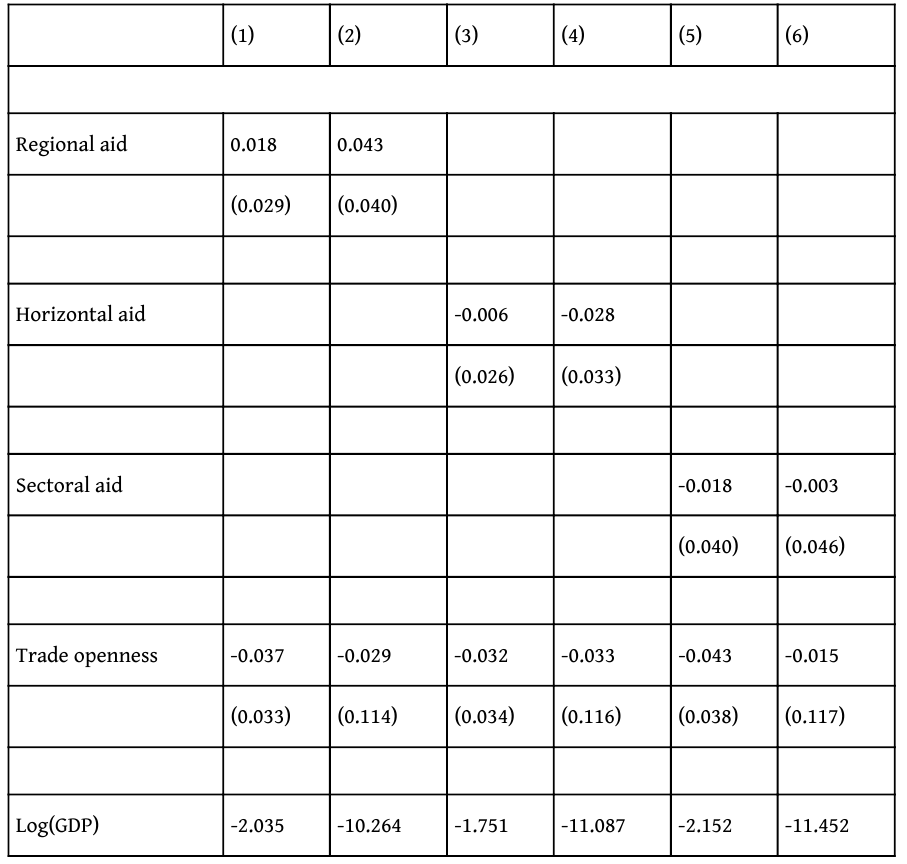
Table A2: The effect of post-SAM aid allocations on FDI openness (2014-18), ADL